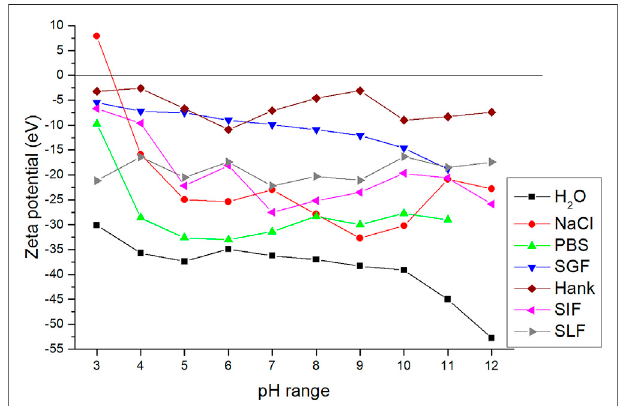
FIGURE 2 | Dependence of zeta potential on pH environment for the CuS NPs in SBF.